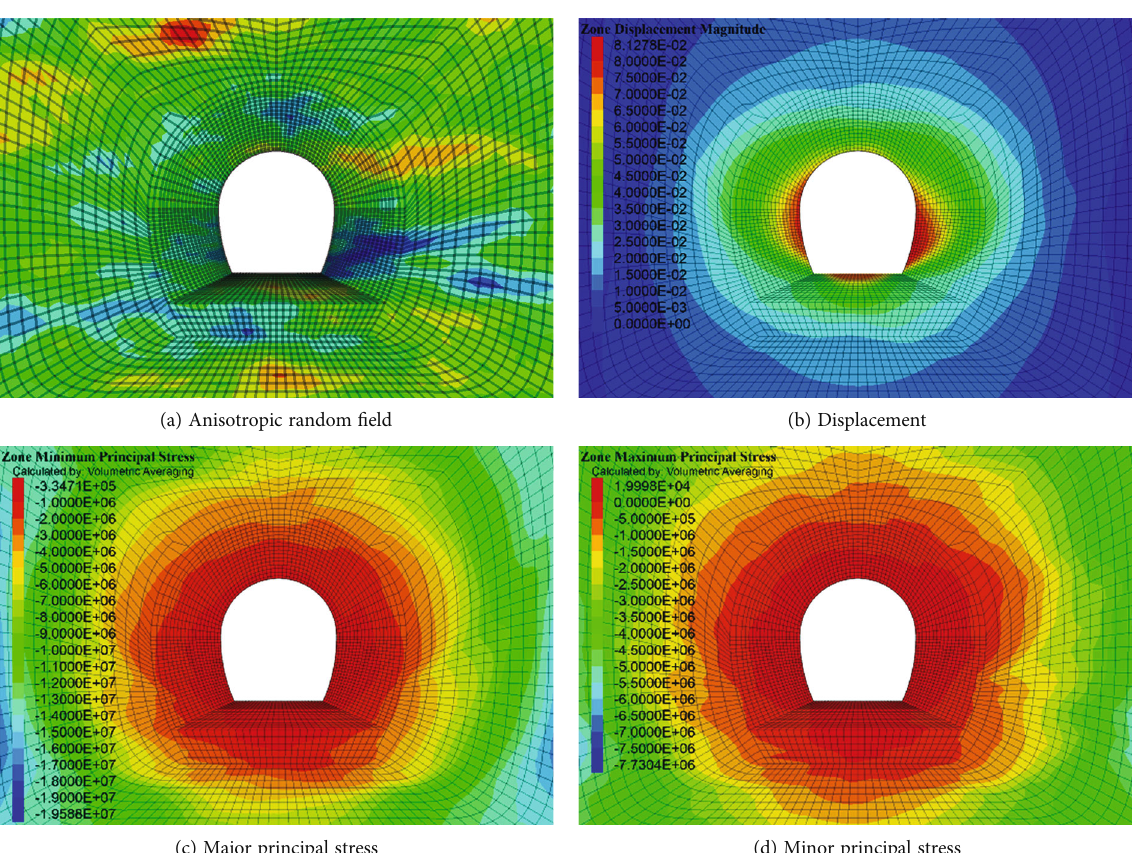
Figure 9: Analysis of cavern excavation results with 0 ° anisotropic fi